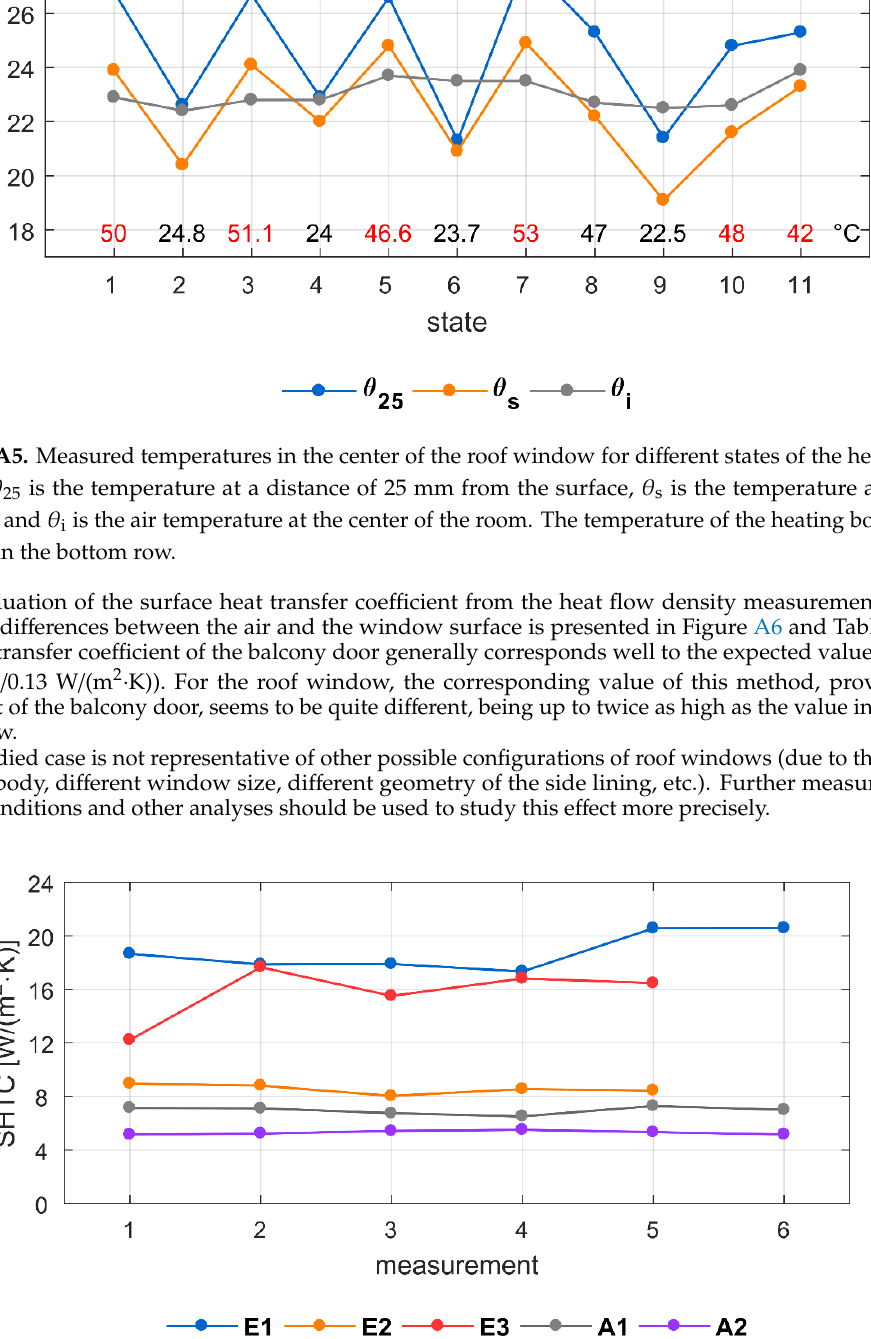
Figure A4. Illustrative single temperature measurement for the roof window — vertical temperature profile along the window. a : a distance of 15 mm from the glazing. b: a distance of 80 mm from the glazing. c, d, and e: glass temperature in the center of the window, at the left edge of the window, and at the right edge of the window, respectively. The indoor air temperature was 21.5 °C, the surface temperature of the heating body was 27 °C, and the exterior air temperature was 0 °C.